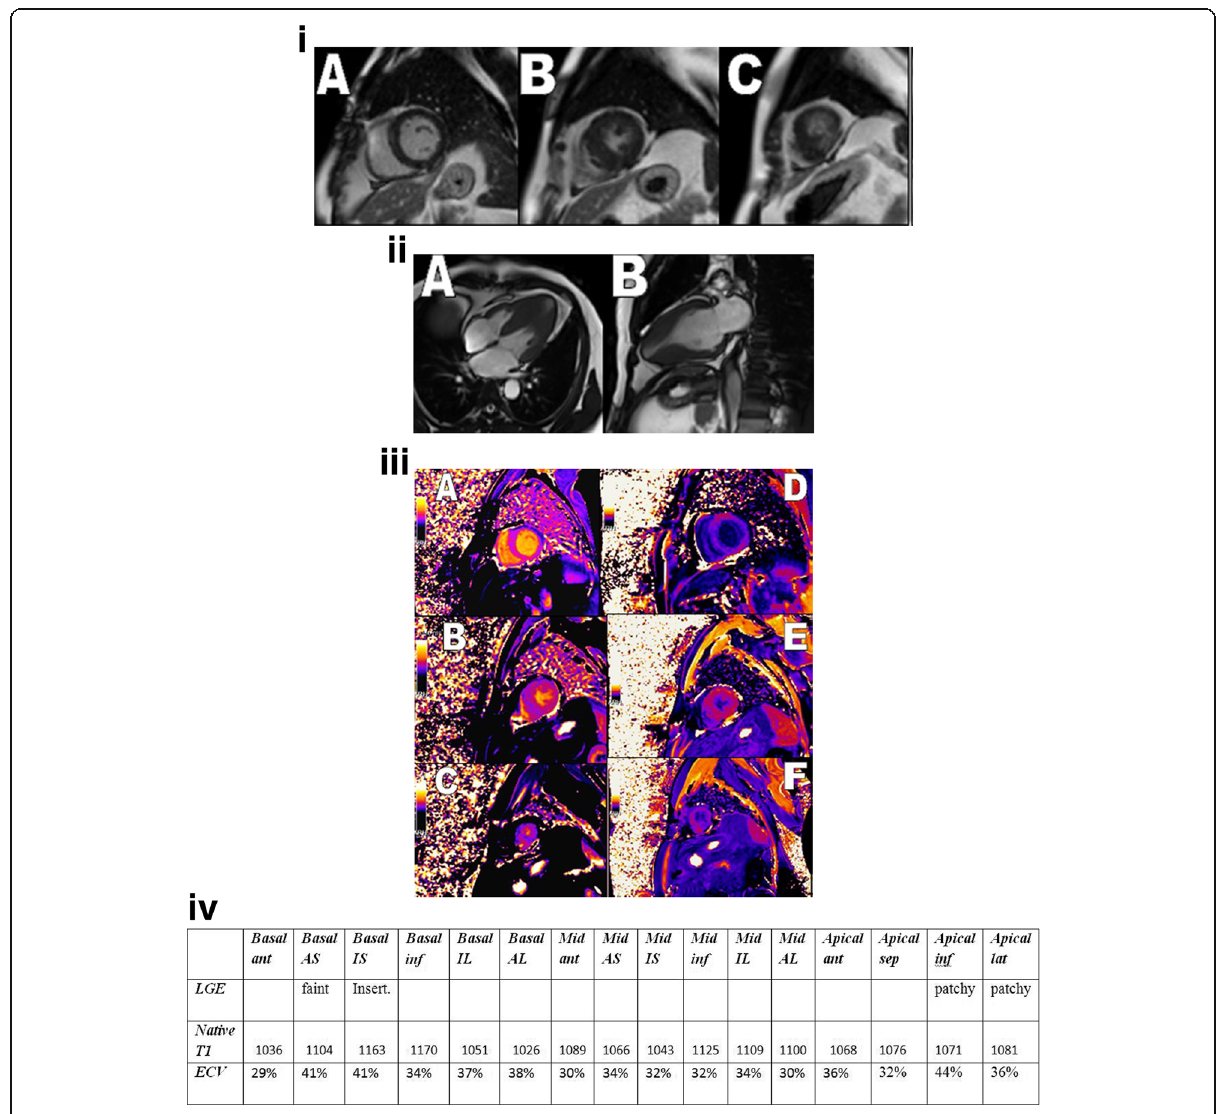
affecting the apical segments, mid-cavitary obstruction with LV mass of 189 g (indexed 106g/m 2 ). I: LGE images at the basal ( a ), mid-ventricular ( b ), and apical ( c ) levels corresponding to the T1 mapping cuts showing faint basal AS segment and inferior insertion point enhancement and patchy enhancement of the apical inferior and lateral segments. II: SSFP images in 4-chamber ( a ) and 2-chamber ( b ) end-systolic views showing mid-ventricular to apical hypertrophy with mid-cavitary obstruction. III: pre-contrast ( a – c ) and post-contrast ( d – f ) T1 mapping images at the basal ( a , d ), mid-ventricular ( b , e ), and apical ( c , f ) levels. IV: enhancement pattern and values of native T1 and ECV at the basal, mid-ventricular, and apical segments showing the expansion of the ECV and elongation of the native T1 values not only in the segments showing enhancement but in other segments as